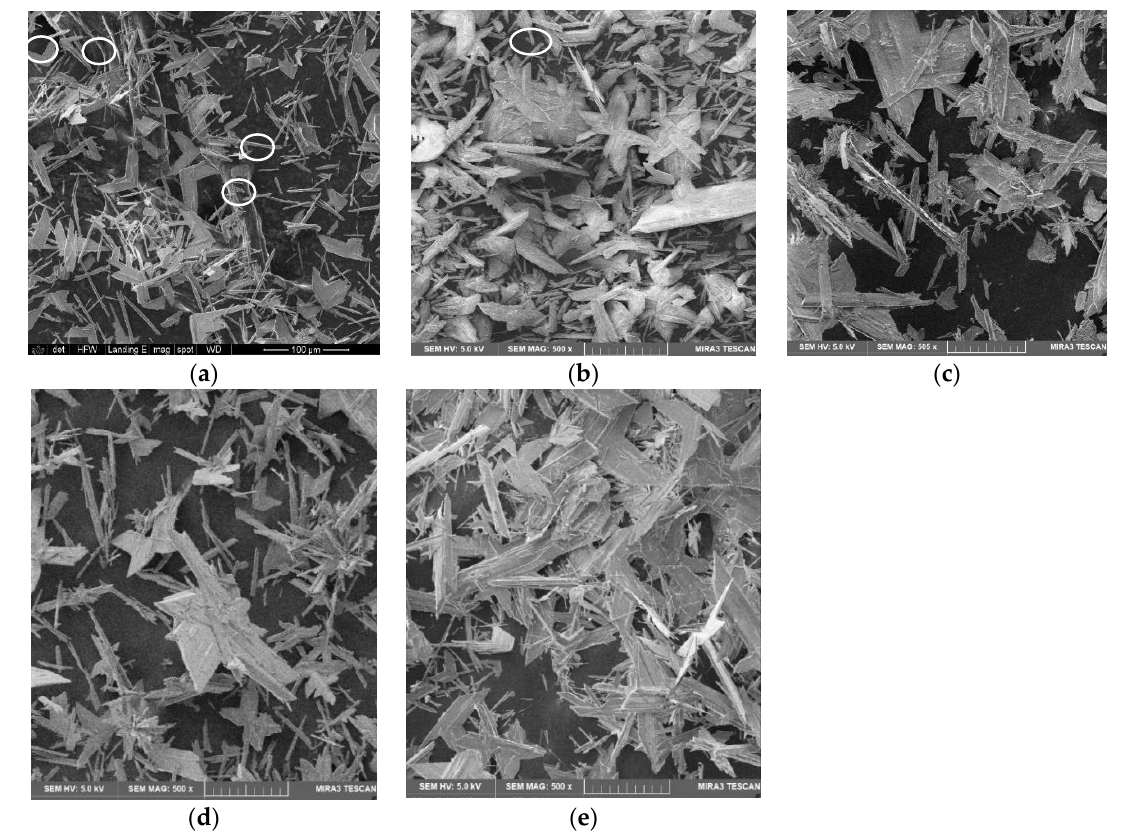
Figure 13. Micrographs of the solid suspension at the end of the experiment ( a ) control experiment, ( b ) C S = 0.04 g/L, ( c ) C S = 0.25 g/L ( d ) C S = 0.50 g/L, and ( e ) C S = 2.01 g/L. Scale bar = 100 µm.